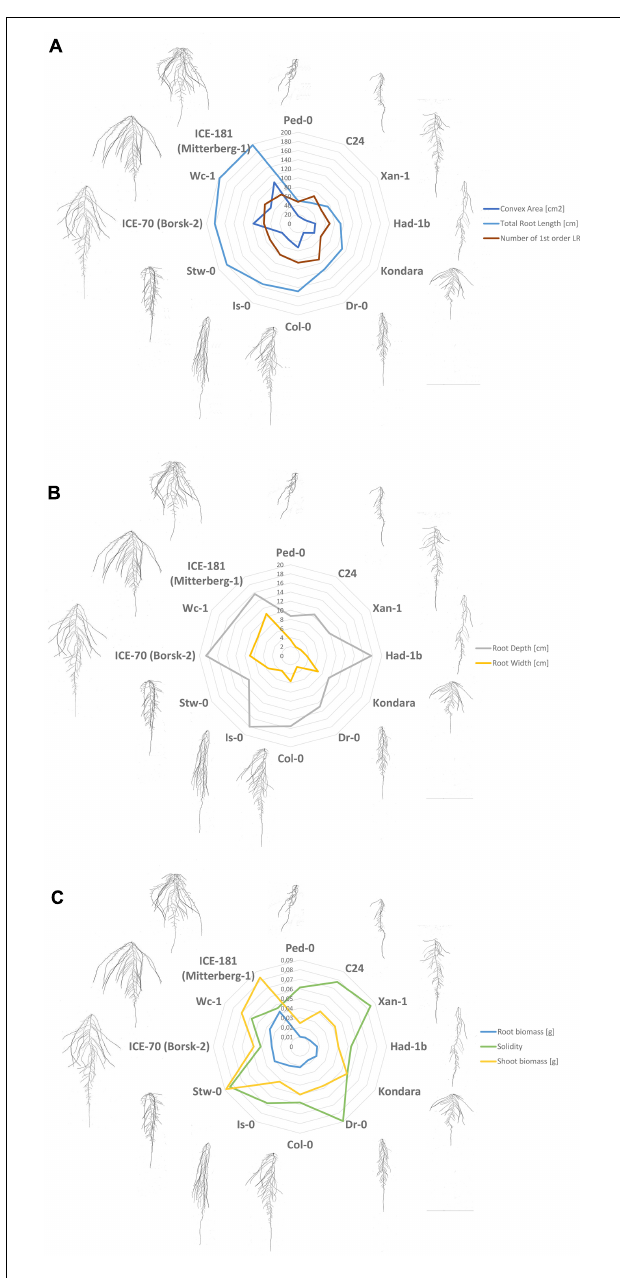
FIGURE 2 | Distribution of RSA traits values for 11 most contrasting accessions and Col-0, represented as scatter plots. (A) Convex area [cm 2